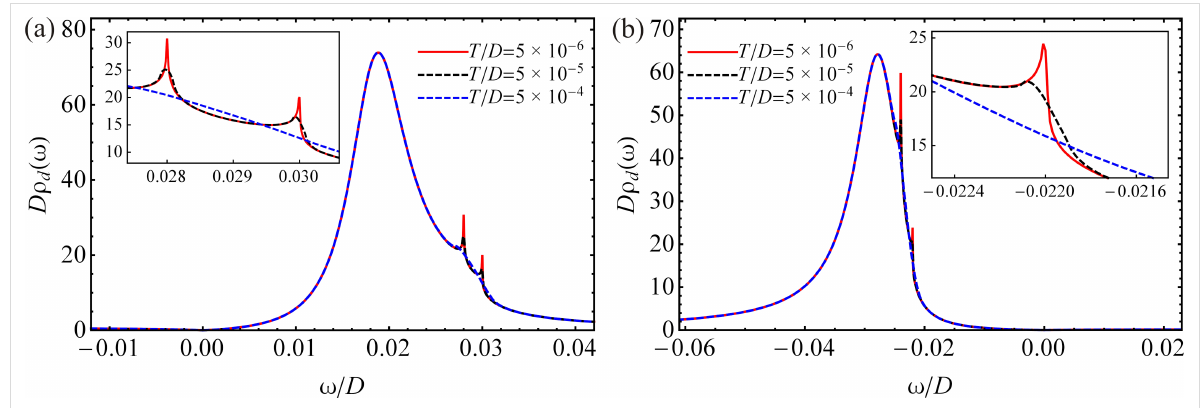
Figure 3: The nonequilibrium DOS in the QD at zero magnetic field for different temperatures with U / D → ∞ and different values of the parameters: (a) μ L / D = 0.028, μ R / D = 0.030, η = 0.02 and ε d / D = − 0.011. (b) μ L / D = − 0.024, μ R / D = − 0.022, η = 0.015 and ε d / D = − 0.068.